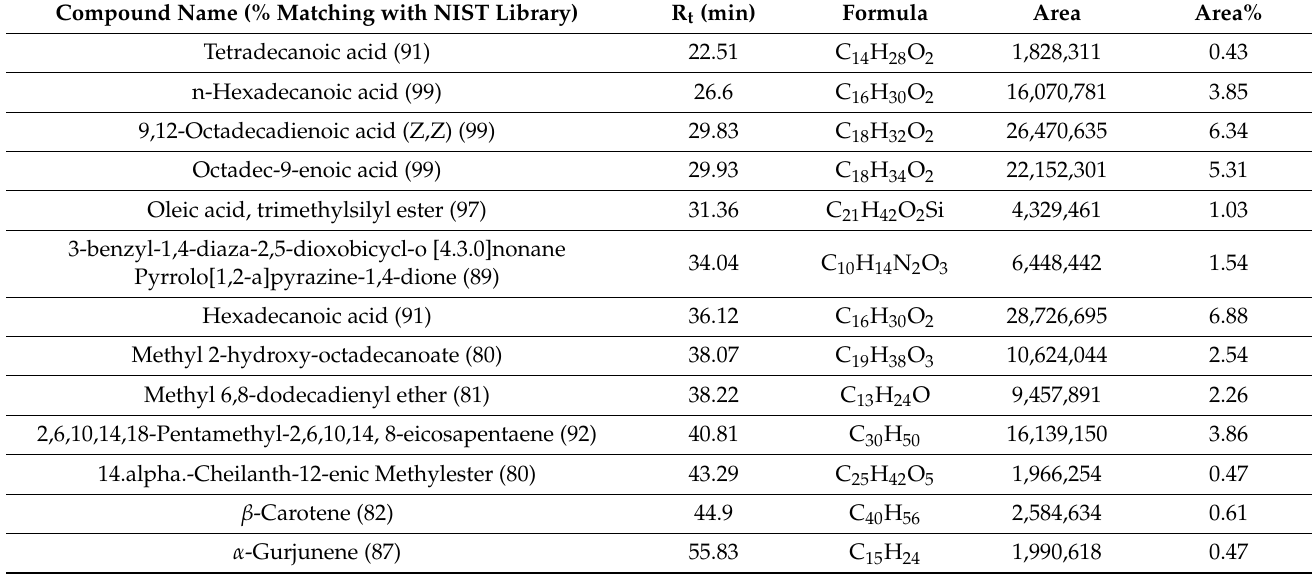
Table 2. GC–MS profiling of TEF and identified major compounds.